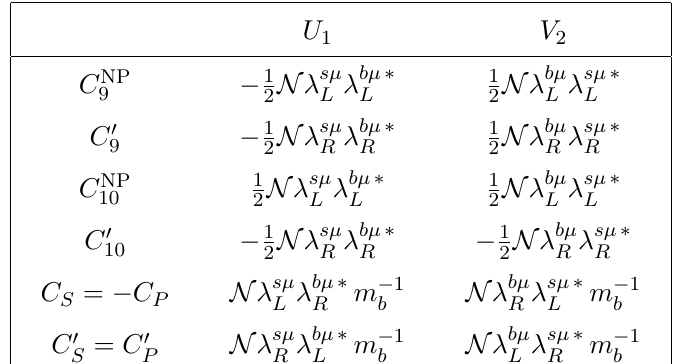
is de(cid:12)ned N